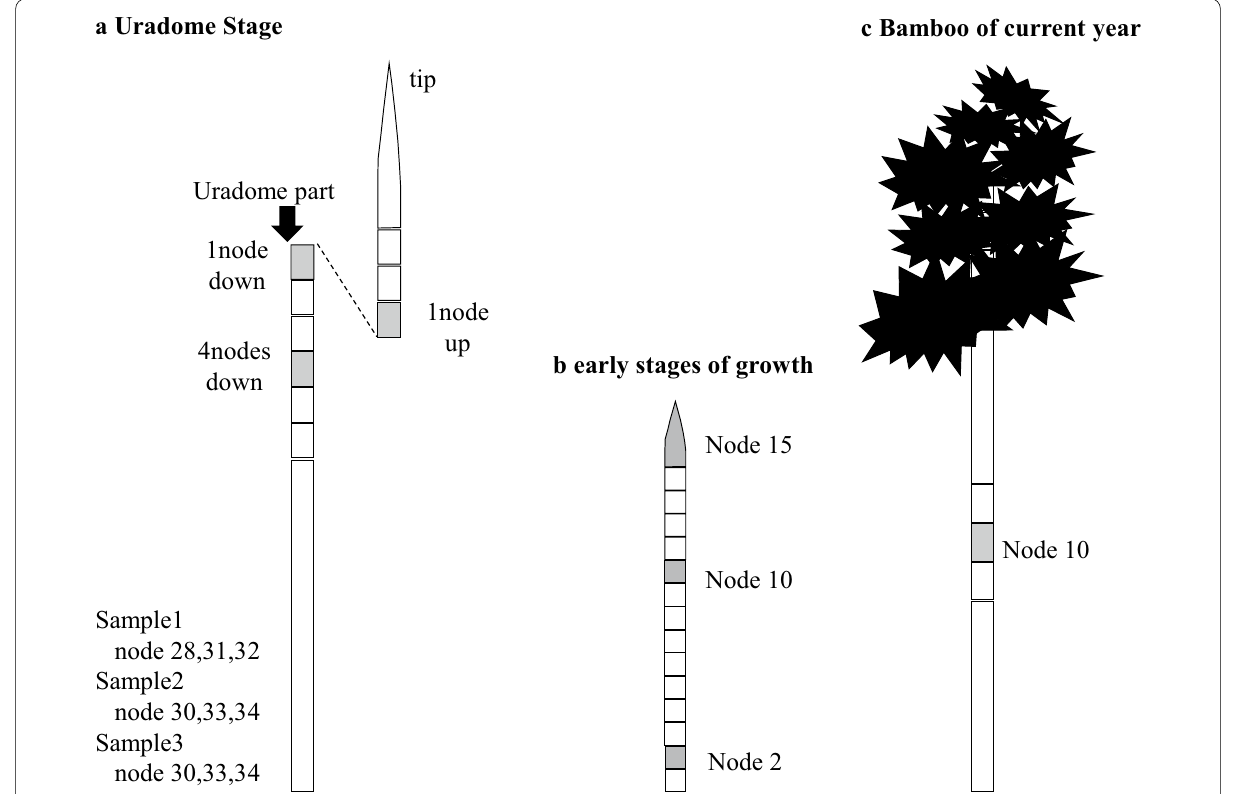
Fig. 1 Nodes used in the experiments at each growth stage. The nodes in the gray area were used for the